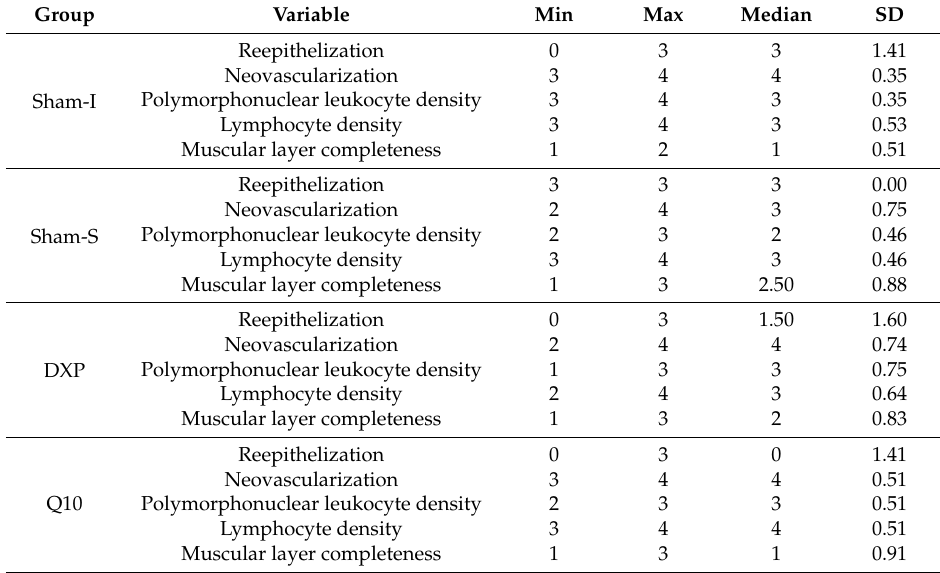
Table 5. Descriptive table of the histopathological grade values of all groups (Min: Minimum, Max: Maximum, SD: Standard deviation).